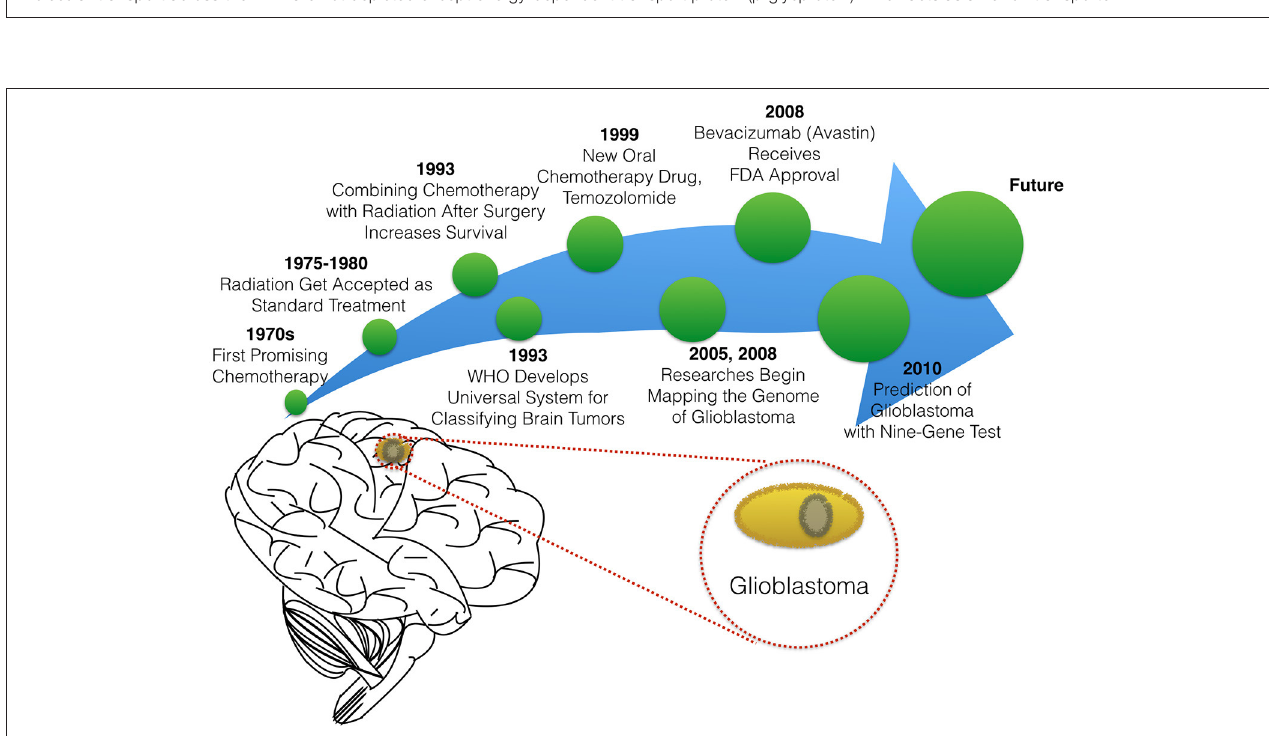
FIGURE 1 | The cross-sectional view of the blood-brain barrier. The blood-brain barrier (BBB) is a physical interface formed by cerebral endothelial cells, separated from pericytes and astrocytic end-feet by the basal lamina. The interactions of the endothelial cells and astrocytes maintaining the integrity of the BBB. Routes for molecular transport across the BBB are not depicted except energy-dependent transport protein (p-glycprotein) which acts as an efflux transporter.